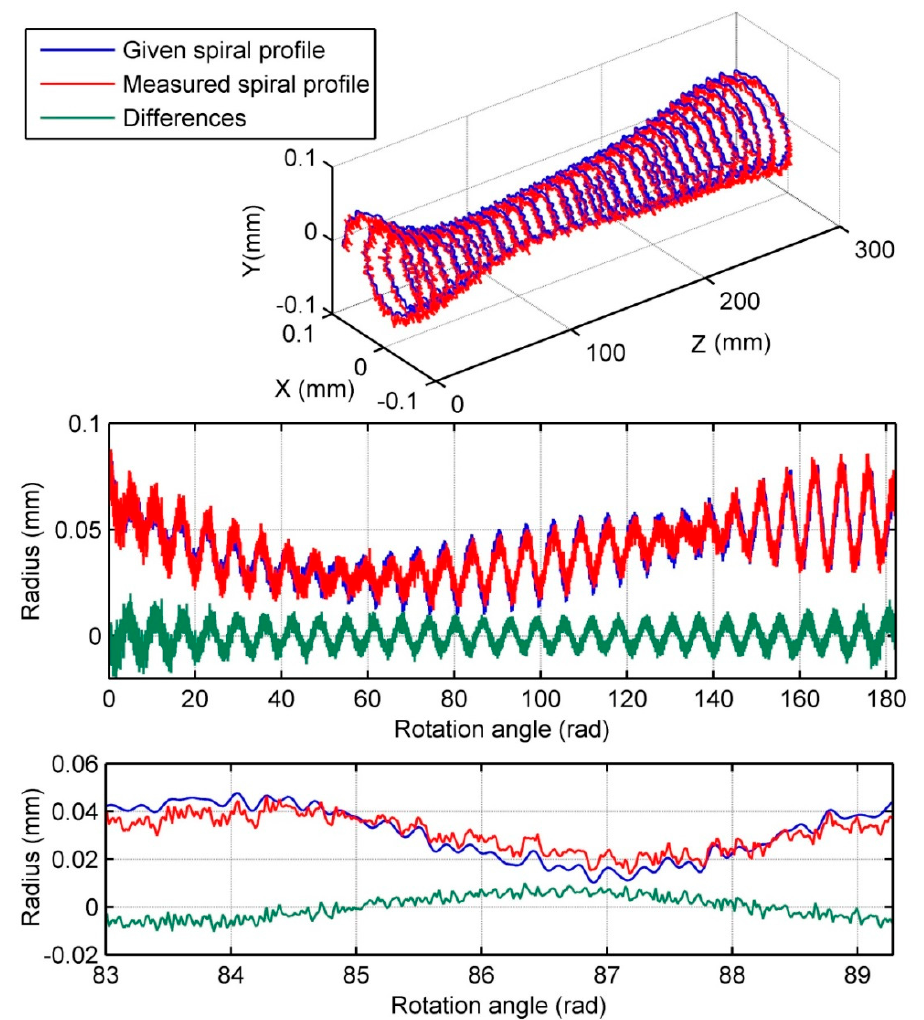
Figure 12. Comparison of the measured spiral line profile with given one in the case of actual measurement. Here, angular position of probes ϕ n ( n = 1,2, · · · ,5 ) is 0 ◦ , 395 ◦ , 838 ◦ , 1236 ◦ , 1659 ◦ , respectively, and pitch of spiral line is T = 10 mm. Number of total rotating circles of spiral line is M = 29 .